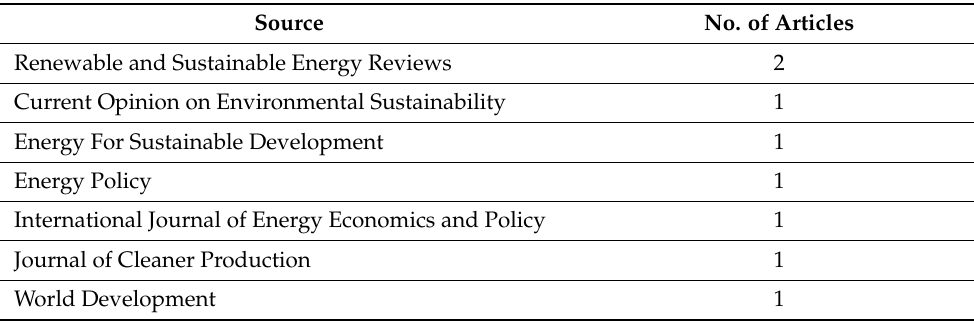
Table 1. Article numbers by journal title.